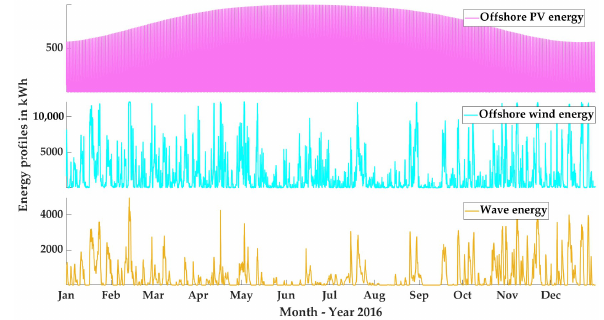
Figure 2. 2016 energy profiles of the studied area in kWh.